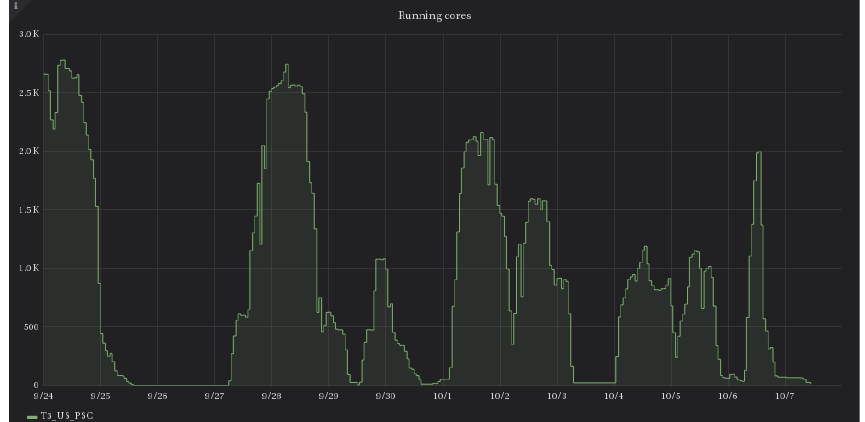
CMS jobs running at PSC during late September and early October 2018. Scale is limited by pilots being submitted, pilots waiting for execution in the Bridges batch queue, pilots running and terminating followed by new pilots being submitted and so on.